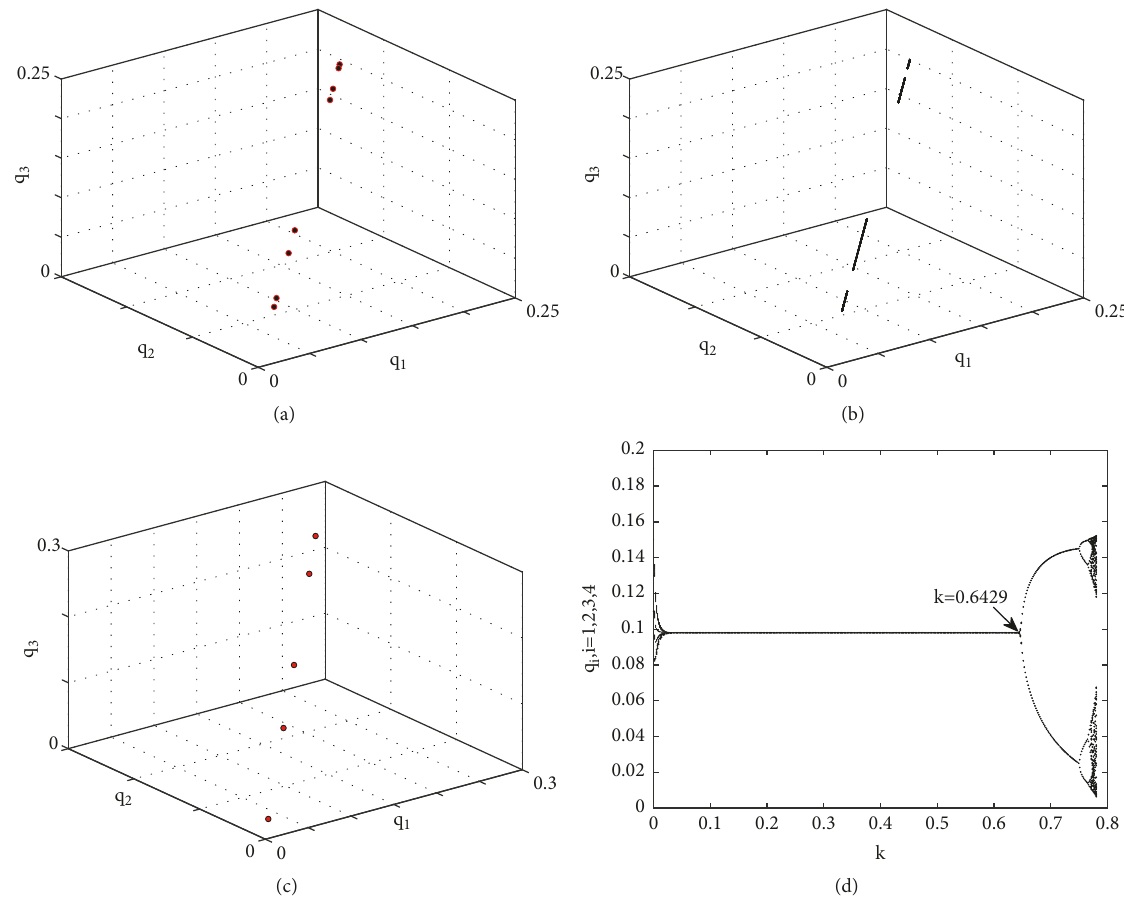
Figure 3: (a) Phase portrait of the period 8-cycle of system (6) at (𝑎, 𝑐, 𝑘, 𝛼, 𝑞 0,1 , 𝑞 0,2 ,𝑞 0,3 , 𝑞 4 ) = (0.91, 0.11, 0.5, 0.19, 0.15, 0.13, 0.11) . (b) Chaotic behavior of system (6) at (𝑎, 𝑐, 𝑘, 𝛼, 𝑞 0,1 ,𝑞 0,2 , 𝑞 0,3 , 𝑞 4 ) = (0.92, 0.11, 0.5, 0.19, 0.15, 0.13, 0.11) . (c) Phase portrait of the period 5-cycle of system (6) at (𝑎, 𝑐, 𝑘, 𝛼, 𝑞 0,1 ,𝑞 0,2 ,𝑞 0,3 , 𝑞 4 ) = (1, 0.11, 0.5, 0.19, 0.15, 0.13, 0.11) . (d) Bifurcation diagram of system (6) with respect to 𝑘 at (𝑎,𝑐,𝛼,𝑞 ,𝑞 , 𝑞 , 𝑞 ) = (0.625, 0.11, 0.75, 0.19, 0.15, 0.13, 0.11) 0,1 0,2 0,3 0,4